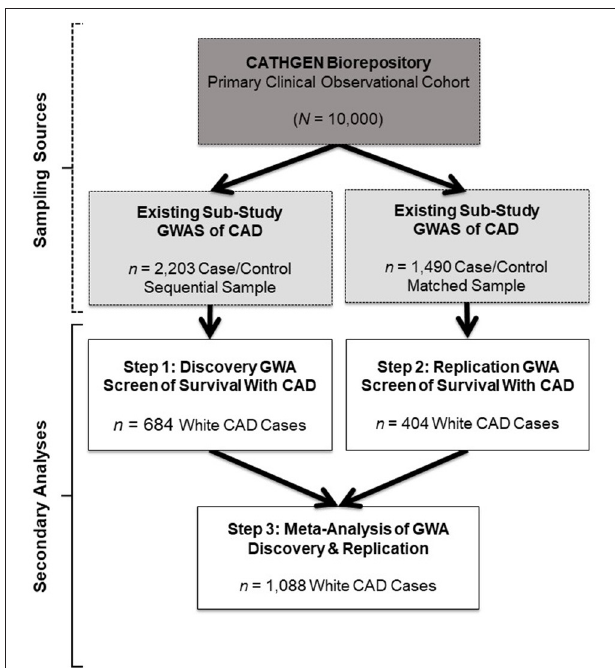
FIGURE 1 | Study design and sample schema. This figure depicts the primary study (dark gray box) and extant sub-study data (light gray boxes) from which our retrospective datasets for the present analyses were derived (white boxes). The CATHGEN Biorepository containing data from 10,000 individuals recruited after cardiac catheterization (dark gray box) supplied the samples for two separate GWASs of CAD sub-studies (light gray boxes), providing the extant GWAS genotype data for our secondary analysis. The first GWAS sub-study contained data from a sequential sample of 2,203 CATHGEN CAD cases and controls (light gray box, left); the other CAD GWAS sub-study had data from 1,490 CATHGEN CAD cases and matched controls (light gray box, right). The white boxes display the secondary datasets we analyzed in the present retrospective study. Specifically, we derived our discovery cohort of 684 White CAD cases (white box, left) from the sequential case-control GWAS data; this discovery dataset was analyzed for Step 1. Our replication cohort of 404 White CAD cases (white box, right) was derived from the matched case-control GWAS dataset; this replication dataset was analyzed for Step 2. We then performed meta-analyses of our discovery and replication cohorts (black arrows converging on the bottom white box) for Step 3.